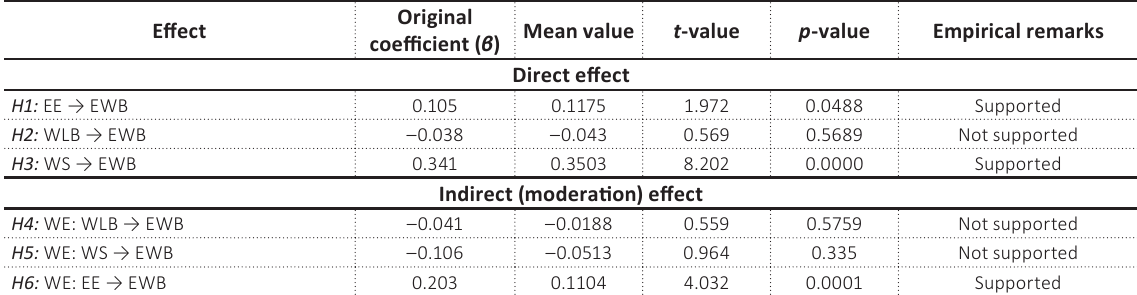
Table 5. Path coefficient for a direct and indirect